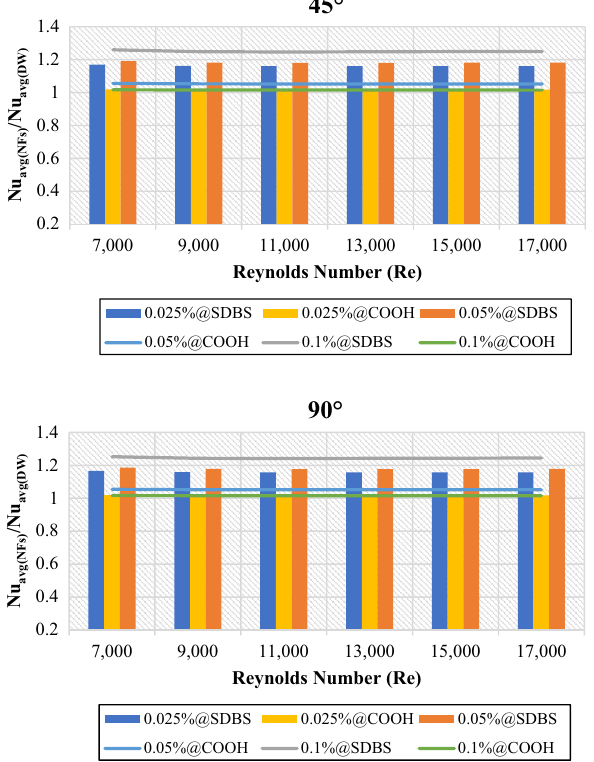
Figure 6. Average Nusselt number of nanofluids to base fluid versus Reynolds numbers for 45° and 90° tubes.